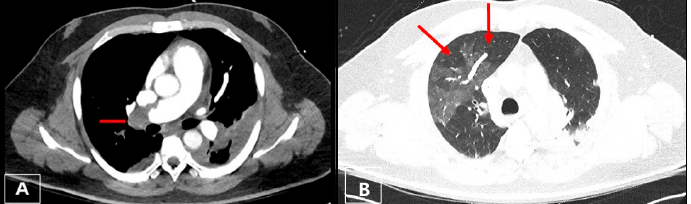
B Figure 6. ( A ) Axial CT image with a central thrombus in the right pulmonary artery (red arrow); ( B ) right lung showing mosaic pattern whereas lucent areas correspond to perfusion defect (right upper lobe, red